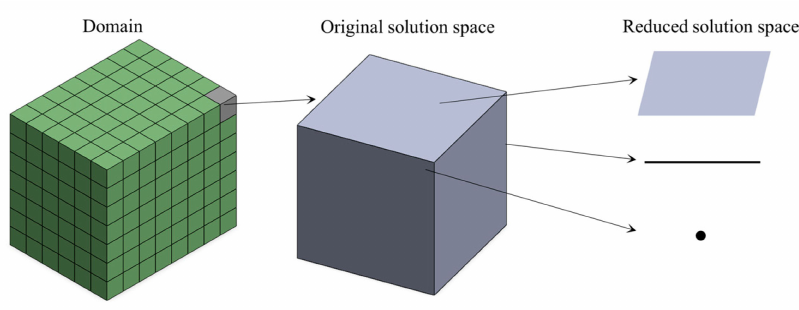
Figure 1. Domain, original solution space, and its reduced solution spaces.